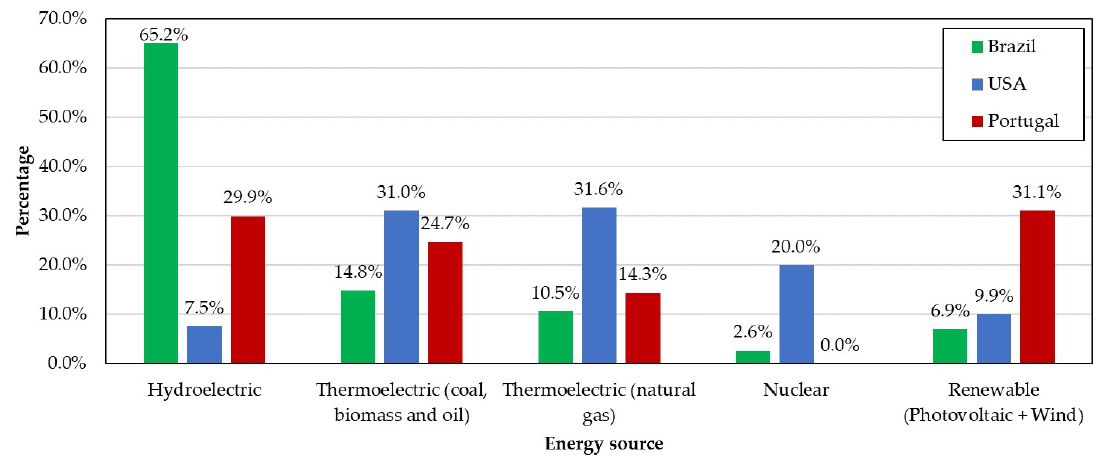
Figure 5. Brazil's electric energy matrix [11].